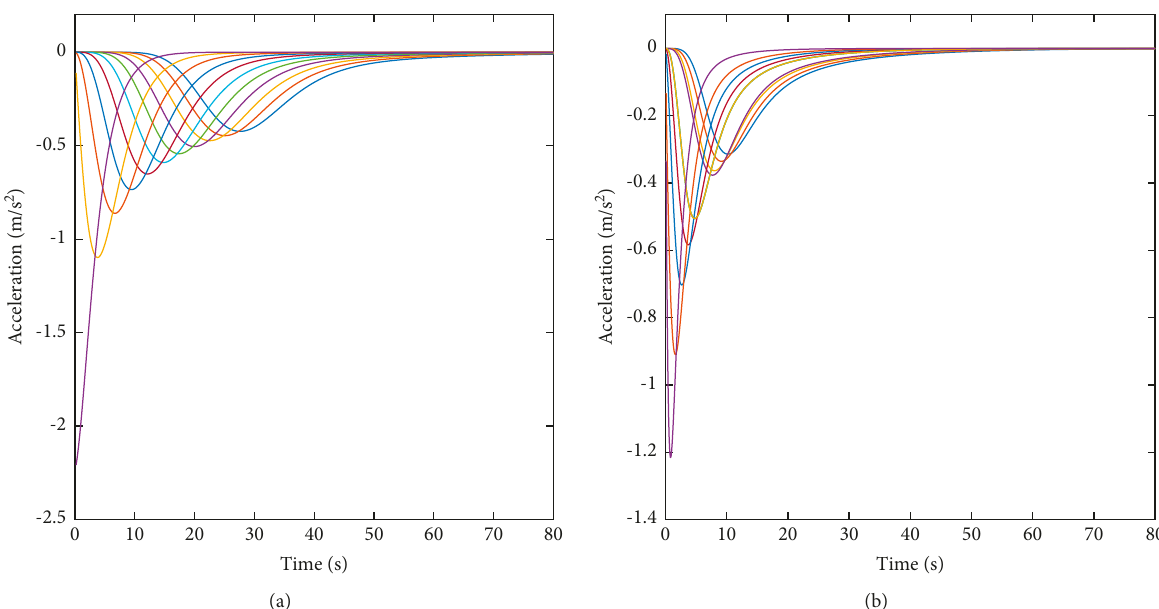
Figure 5: Acceleration’s evolution of eleven vehicles during the arrival process simulated by the FVD and IH models. (a) FVD model. (b) IH model.